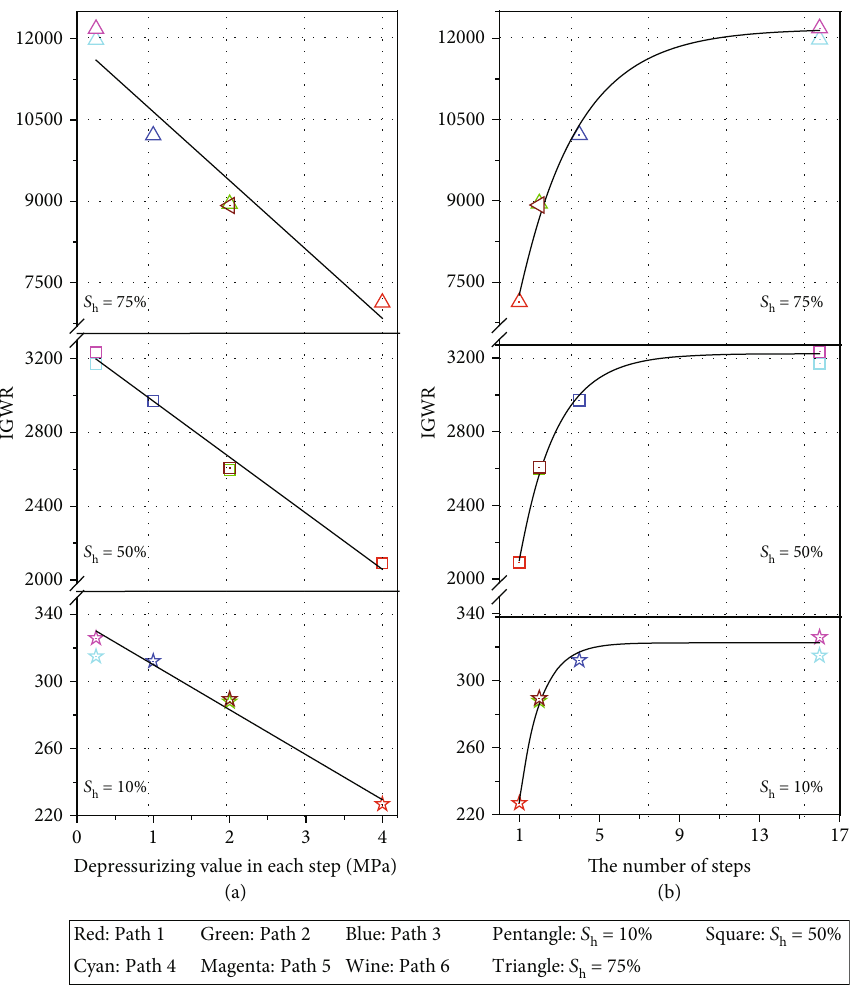
Figure 7: The in fl uence of depressurizing magnitude in each step and the number of steps on the IGWR when the total pressure drop is 4MPa.